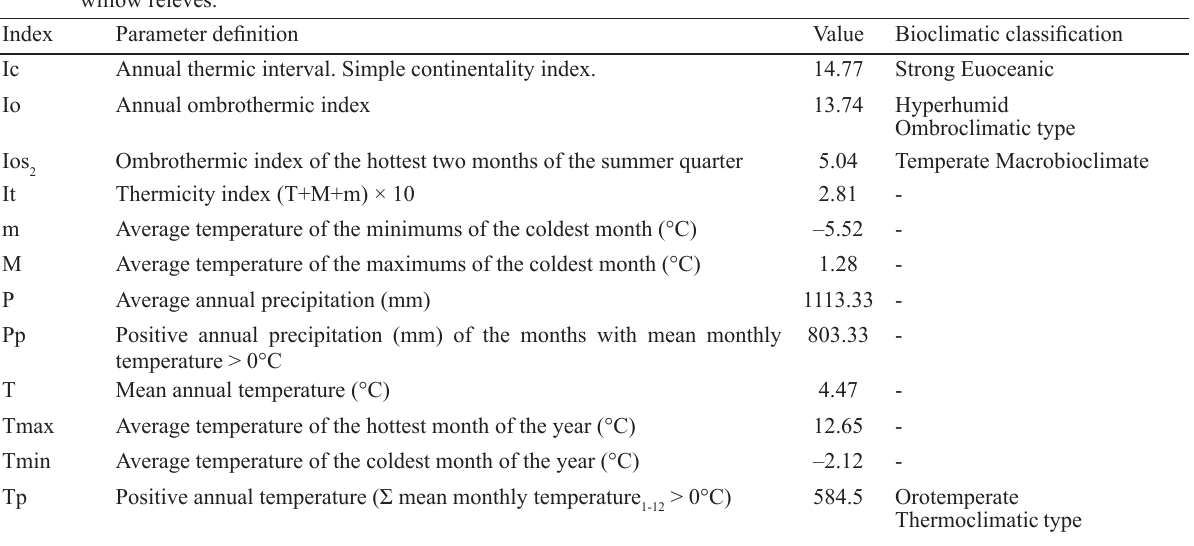
Table 4. Mean values (n = 6) of the bioclimatic indexes and parameters and the corresponding classification, sensu Rivas-Martínez et al. (2017b) calculated from the thermo-pluviometric data of Hijmans et al . (2005) for the locations of finely-toothed willow relevés.